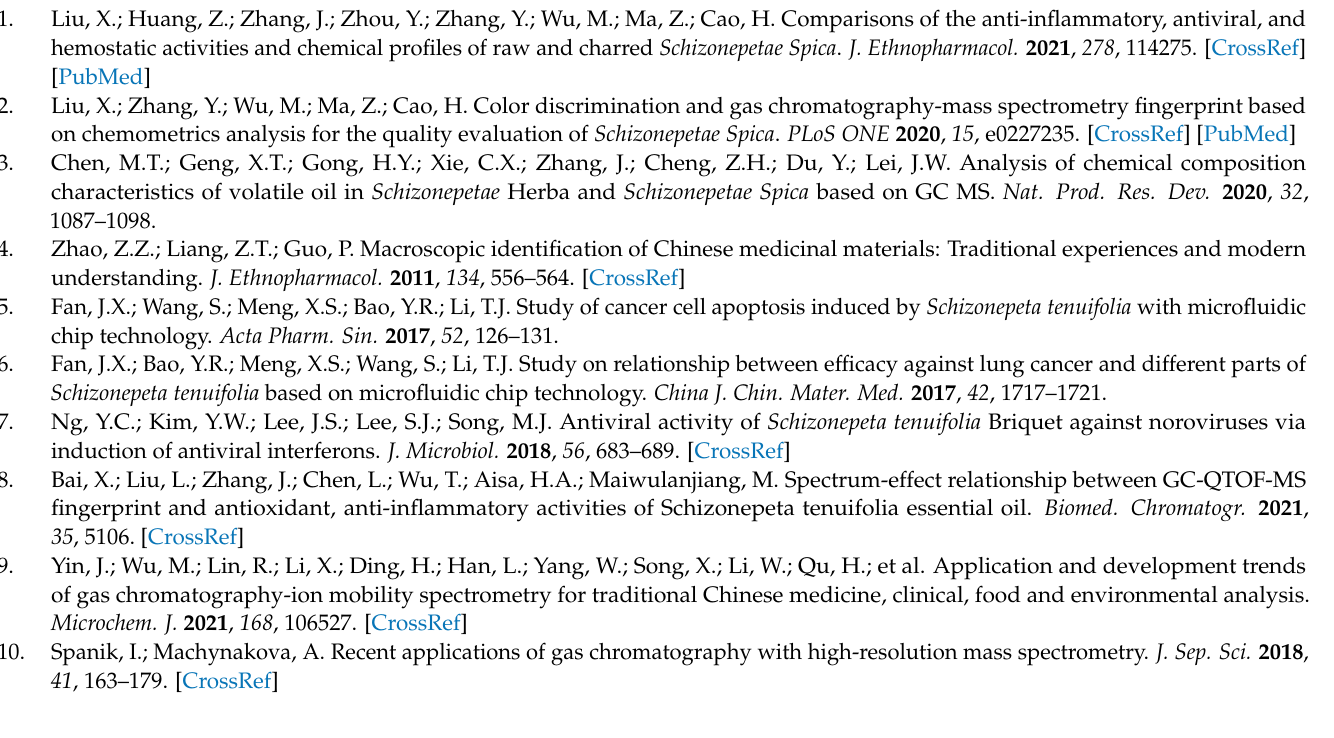
samples. Table S2: Peak area of standard product. Table S3: Peak area of sample determined by HS-SPME-GC-MS. Table S4: Peak area of sample determined by